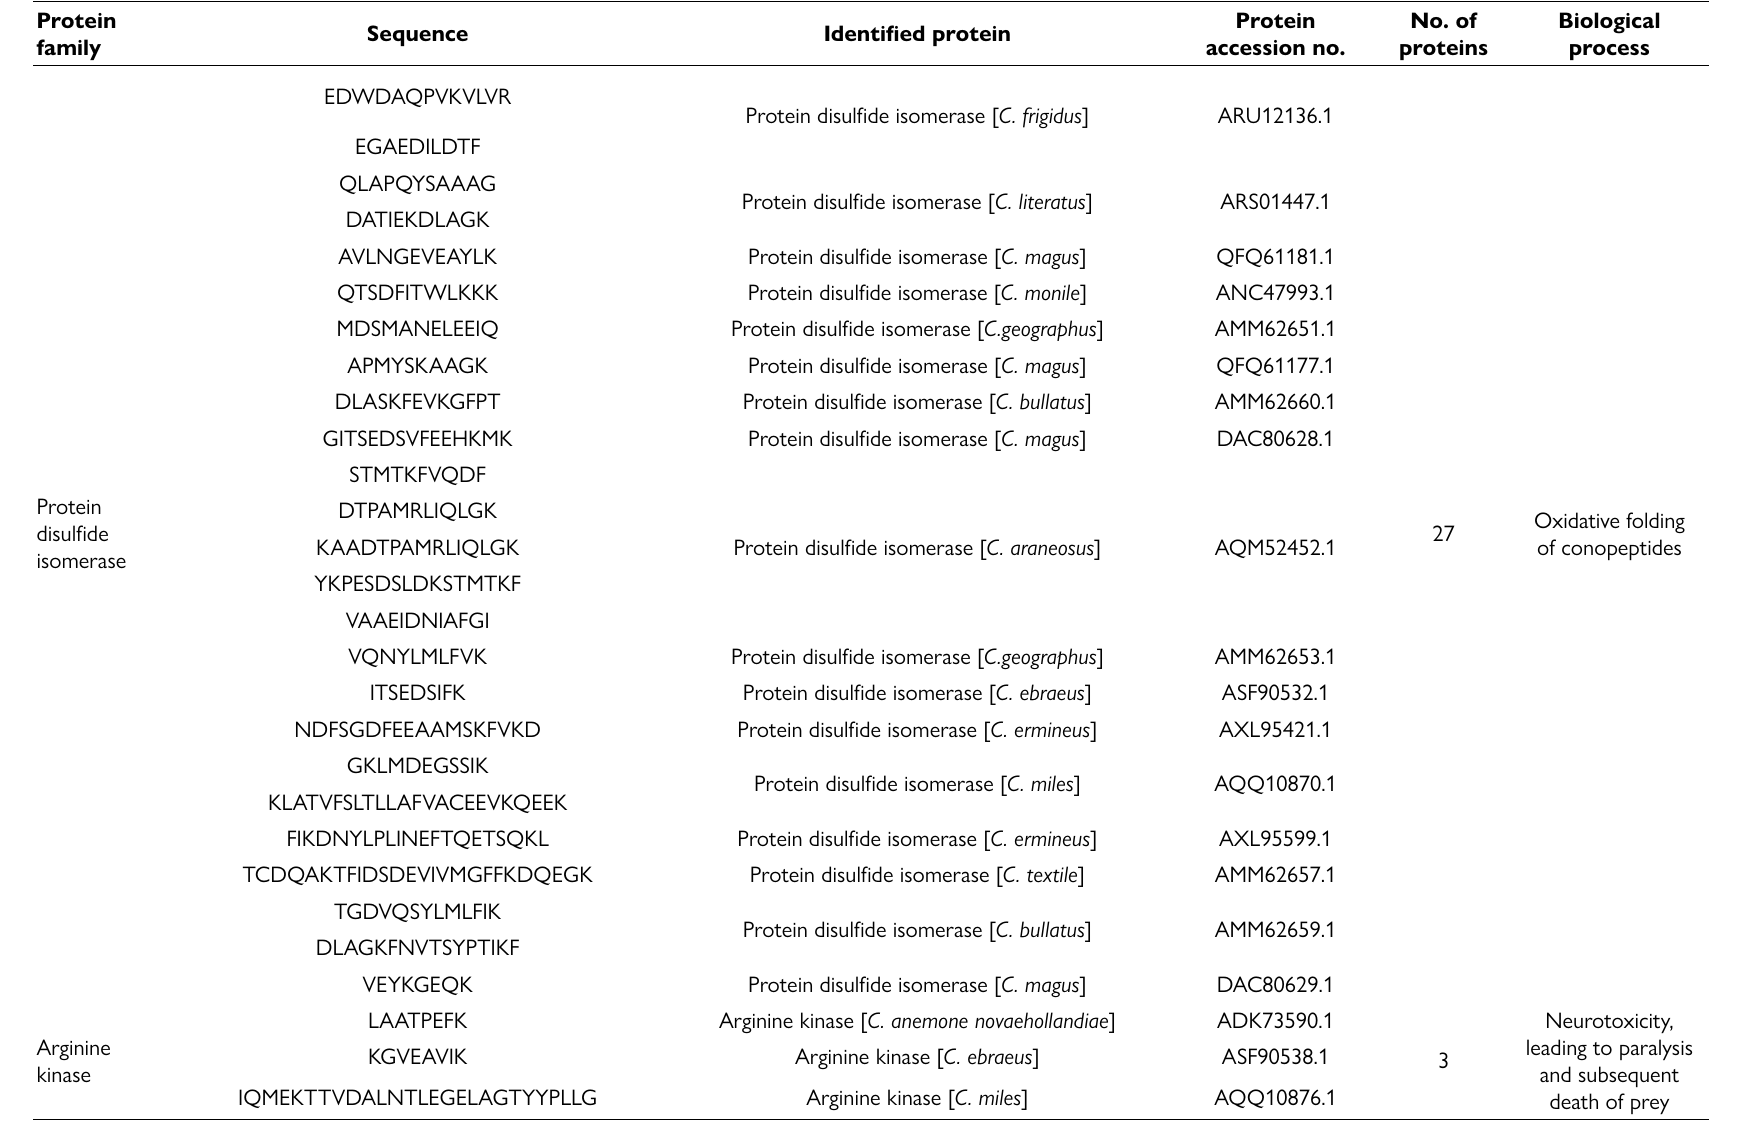
Table 2. Protein family